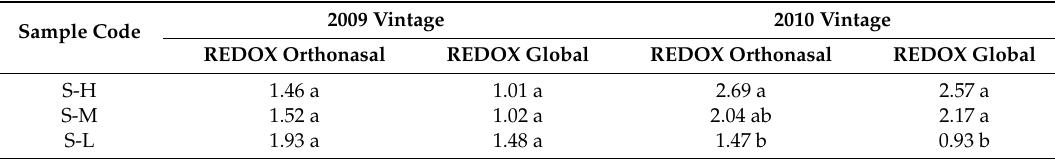
Table 5. Average scores for orthonasal and global REDOX odor assessment of the three turbidity levels for 2009 and 2010 vintages followed by Newman-Keuls’ tests (α = 5%).